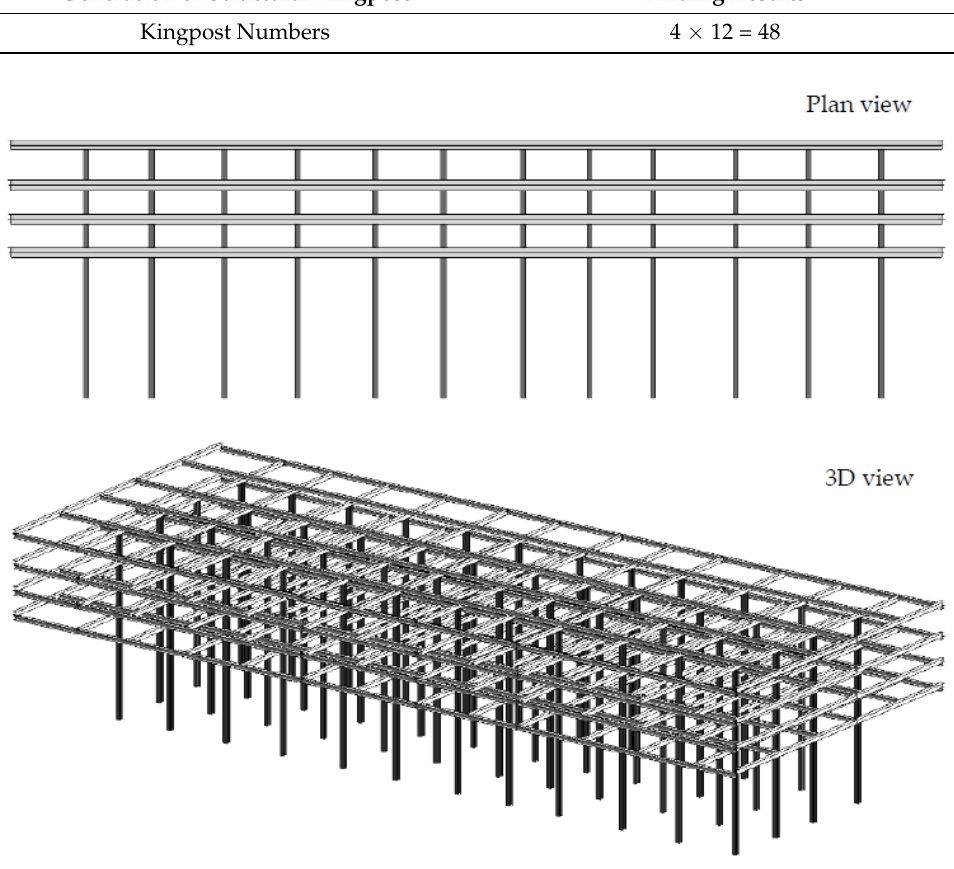
Figure 18. An initial structural kingpost generation in plan and 3D views.